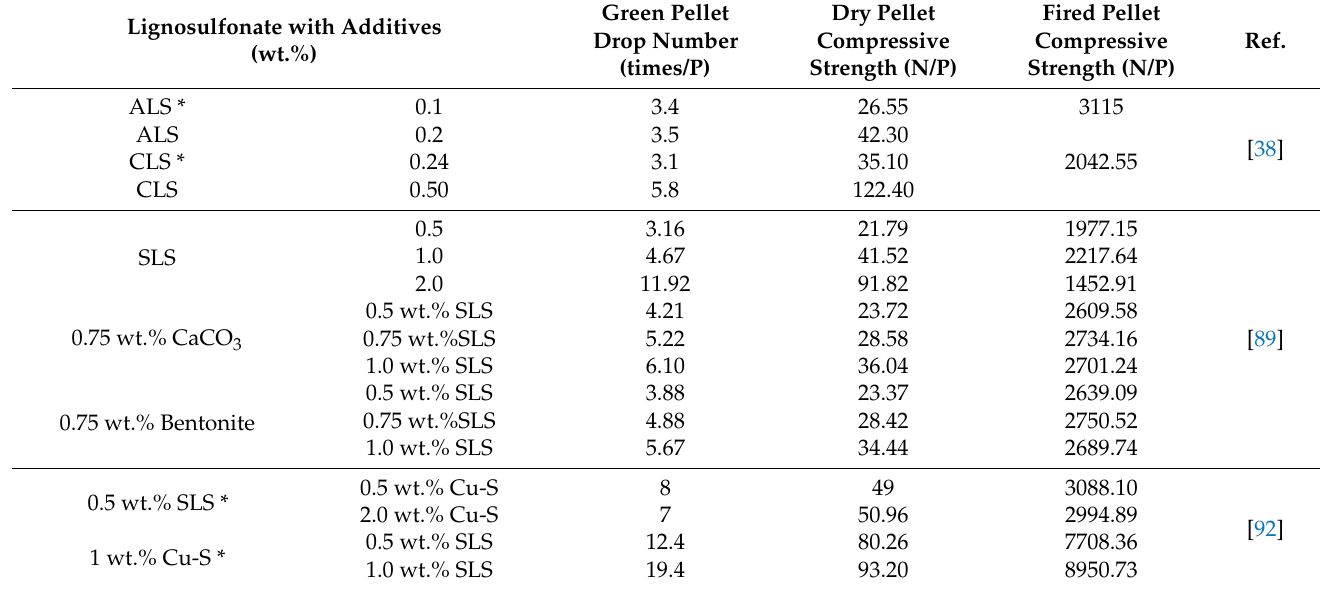
Table 4. The effect of Lignosulfonate with additives on the performance of pellets. Lignosulfonate with Additives